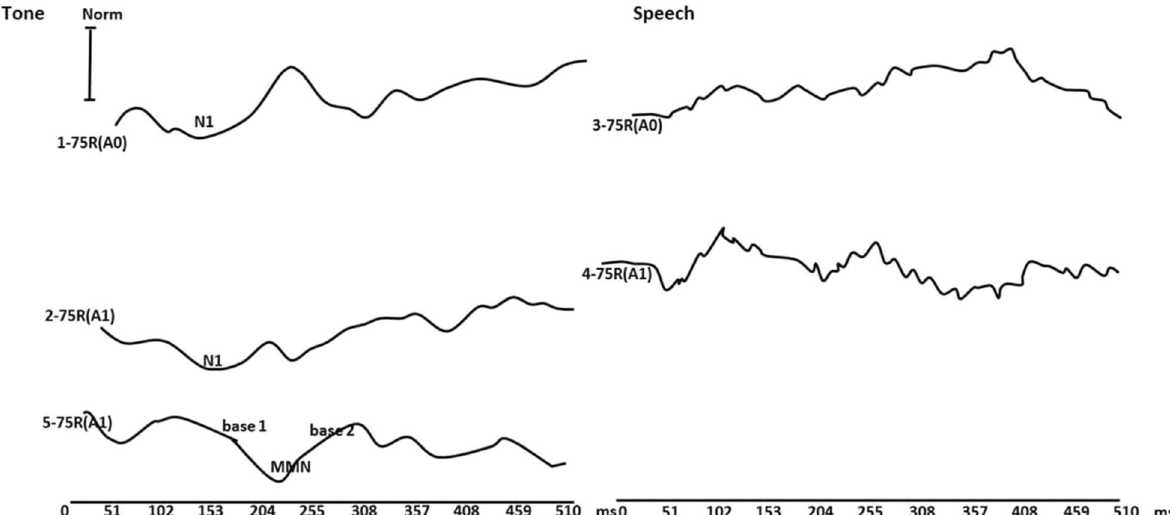
Fig. 3 Presence of MMN response when using tone stimuli and their absence when using speech stimuli in chronic schizophrenic